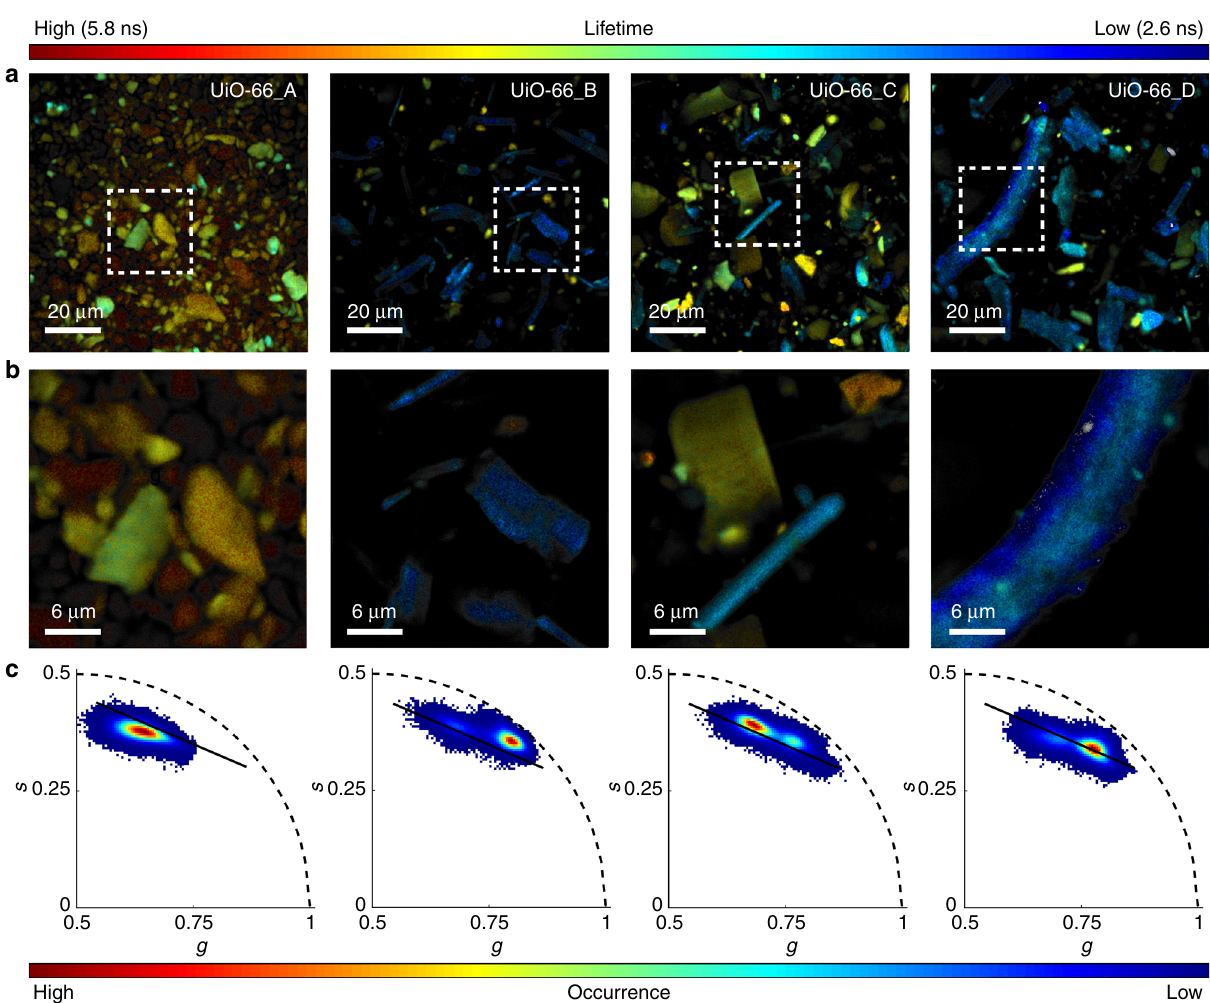
Fig. 3 Fluorescence lifetime imaging microscopy (FLIM) studies of monoliths UiO-66_A-D. To investigate the sub-structural morphologies of the UiO-66 monoliths using FLIM, the monoliths were fi rst gently ground into smaller pieces with a spatula such that the substructures could be monitored on the microscope. a Low and b high-magni fi cation FLIM images of mono UiO-66_A-D showing the aggregates that comprise each monolith. White dashed boxes indicate the area selected for high-magni fi cation imaging. Colours correspond to excitation lifetime (see upper colour bar). c Two-dimensional histogram phasor plots generated from FLIM images of each monolith (an average of four images was used to generate each plot, Supplementary Figs. 4 – 7). Colours correspond to the frequency of occurrence (see lower colour